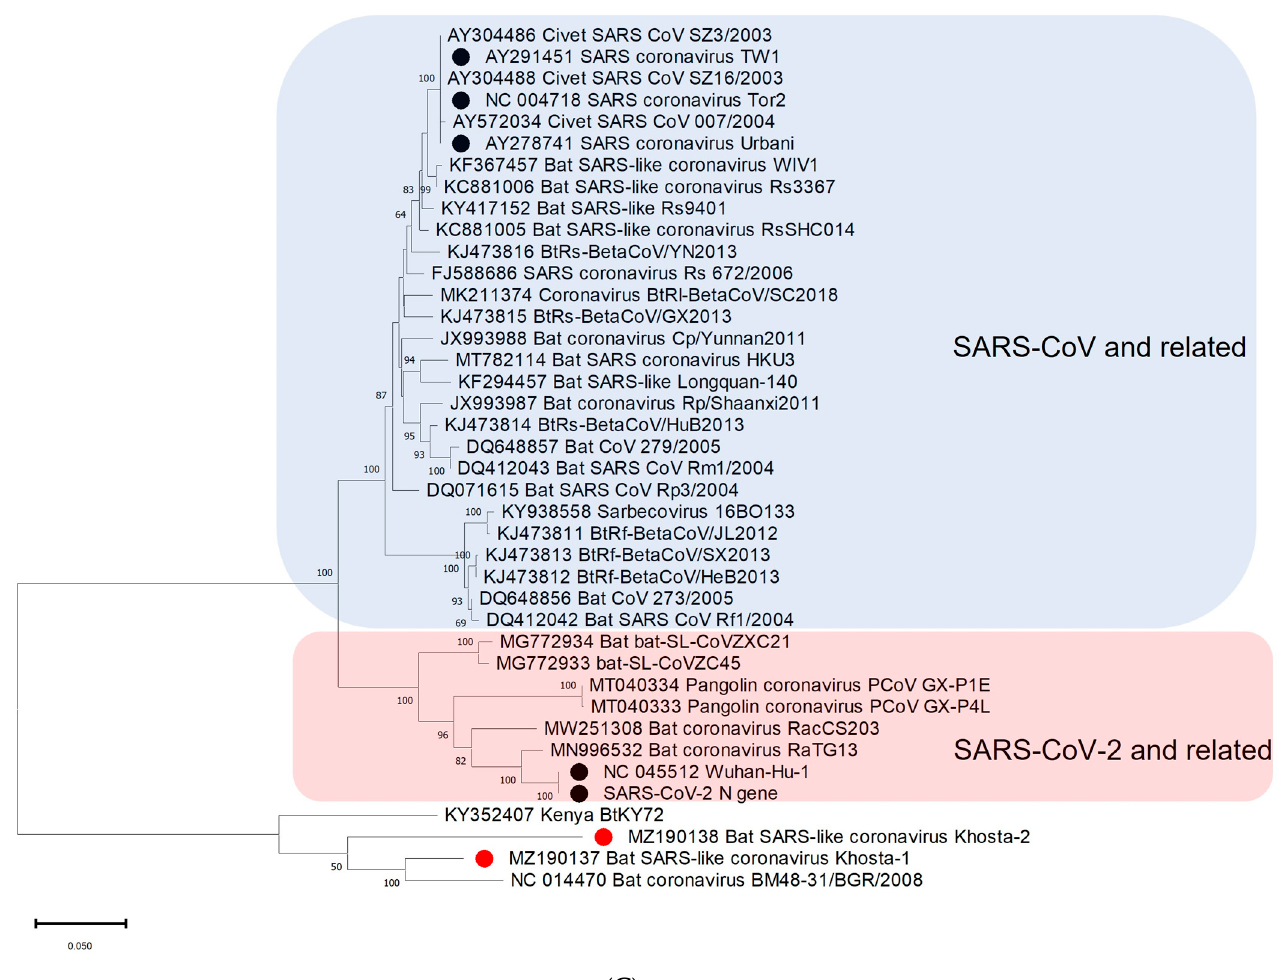
Figure 3. Phylogenetic trees inferred using maximum likelihood method according to an analysis of nucleotide sequences of the RdRp gene (2766 nt) ( A ), nucleotide sequences of the S gene (3822 nt (SARS-CoV-2 numbering)) ( B ), and nucleotide sequences of N gene (1257 nt) ( C ) of certain sarbe- coviruses. The percentage of trees in which the associated taxa clustered together is shown next to the branches (values higher 50% are shown). SARS-CoV and SARS-CoV-2 are marked by black circles; Khosta-1 and Khosta-2, described in the present work, are marked by red circles. The trees were inferred using GTR + G + I model with 1000 bootstrap replicates using the MEGAX.